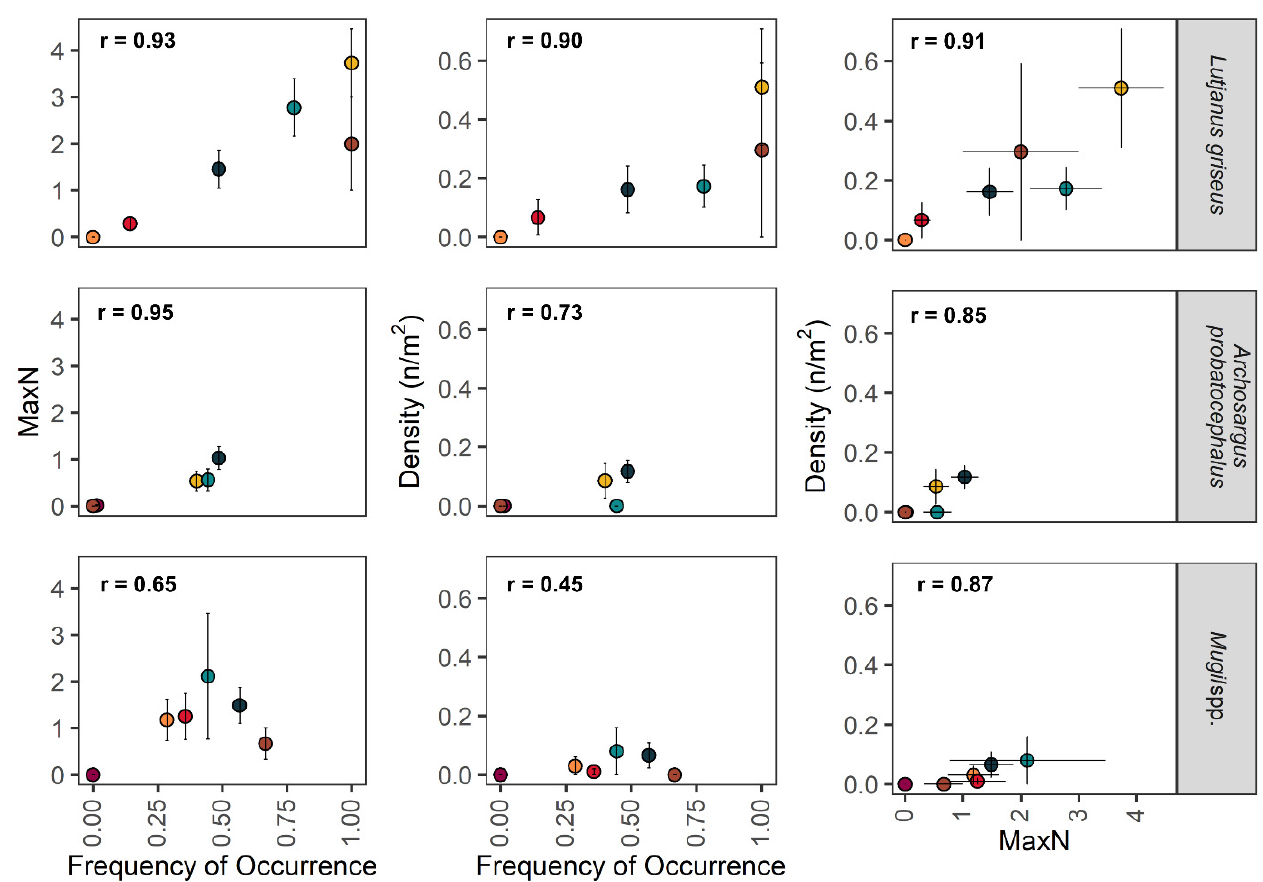
Figure 4. Comparison of abundance metrics (MaxN, Frequency of Occurrence, Density) for repre- sentative common species. Each point represents the mean metric for each habitat type. Error bars represent standard error. Pearson correlation coefficients are presented in each panel. Symbols as per Figure 1 Legend.